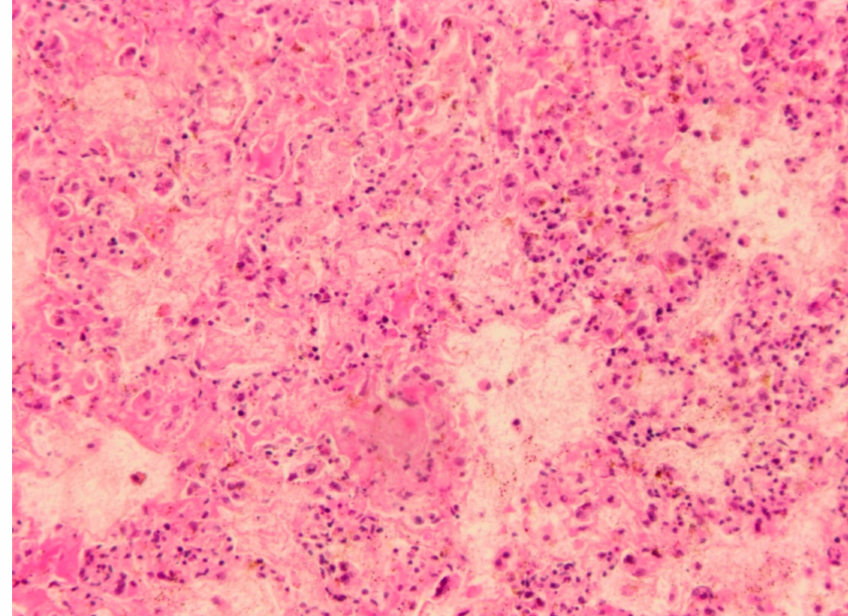
Figure 3. Microscopic finding in Female 1. Infiltration of alveolar septa by mononucleated cells and